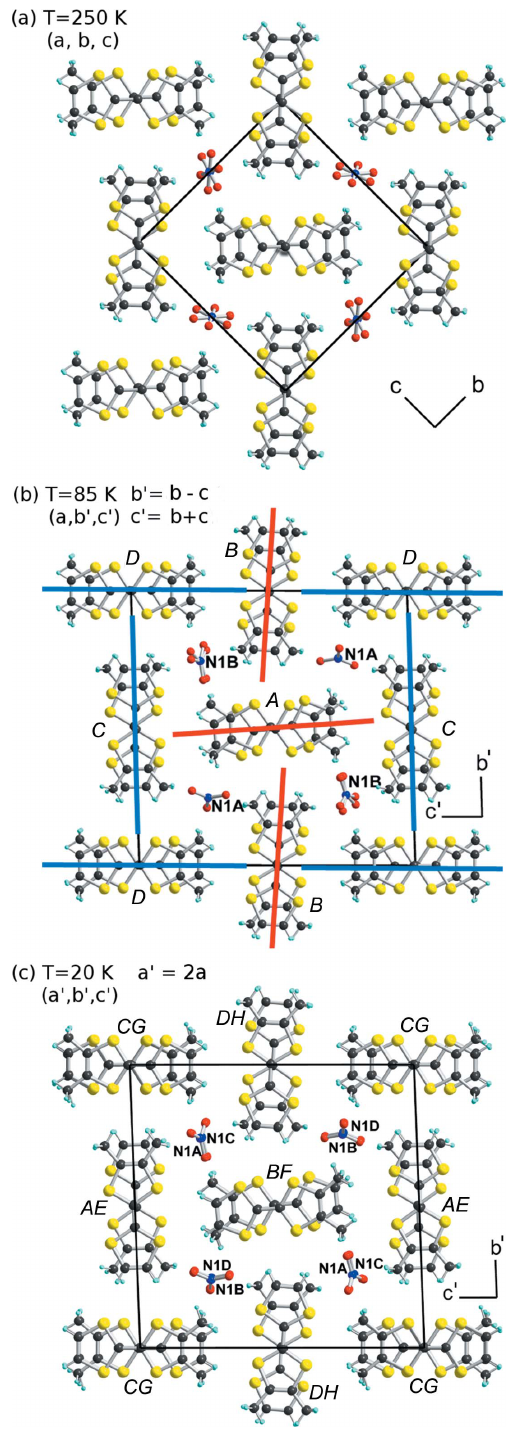
Figure 3 Projection views along a (or a 0 ) of the unit cell of ( o -Me 2 TTF) 2 NO 3 at different temperatures. ( a ) T = 250 K. The NO 3 (cid:2) anions are disordered between two centrosymmetric positions. ( b ) T = 85 K in the q 1 = (0, 1 , 1 ) 2 2 superstructure. Only the majority orientation (93.5%) of the nitrate anion on atom N1 A is shown for clarity. The red and blue lines parallel to the molecular long axes illustrate the rotations of the stacks taking place in this intermediate q 1 = (0, 1 , 1 ) structure to accommodate the two different 2 2 NO 3 (cid:2) orientations. ( c ) T = 20 K in the q 1 + q 2 = ( 1 , 1 , 1 ) 2 2 2